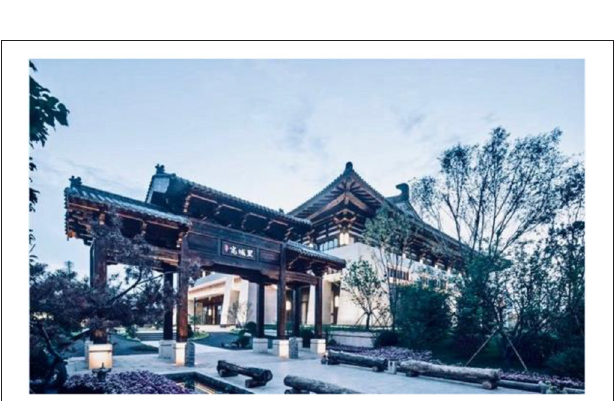
FIGURE 4 | Old residential buildings (Source: Authors).